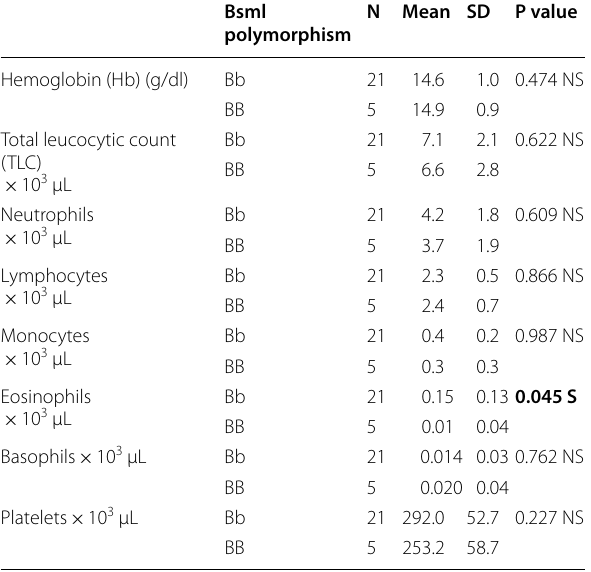
Table 6 Blood cells profile in relation to Bsml gene polymorphism among obese male medical